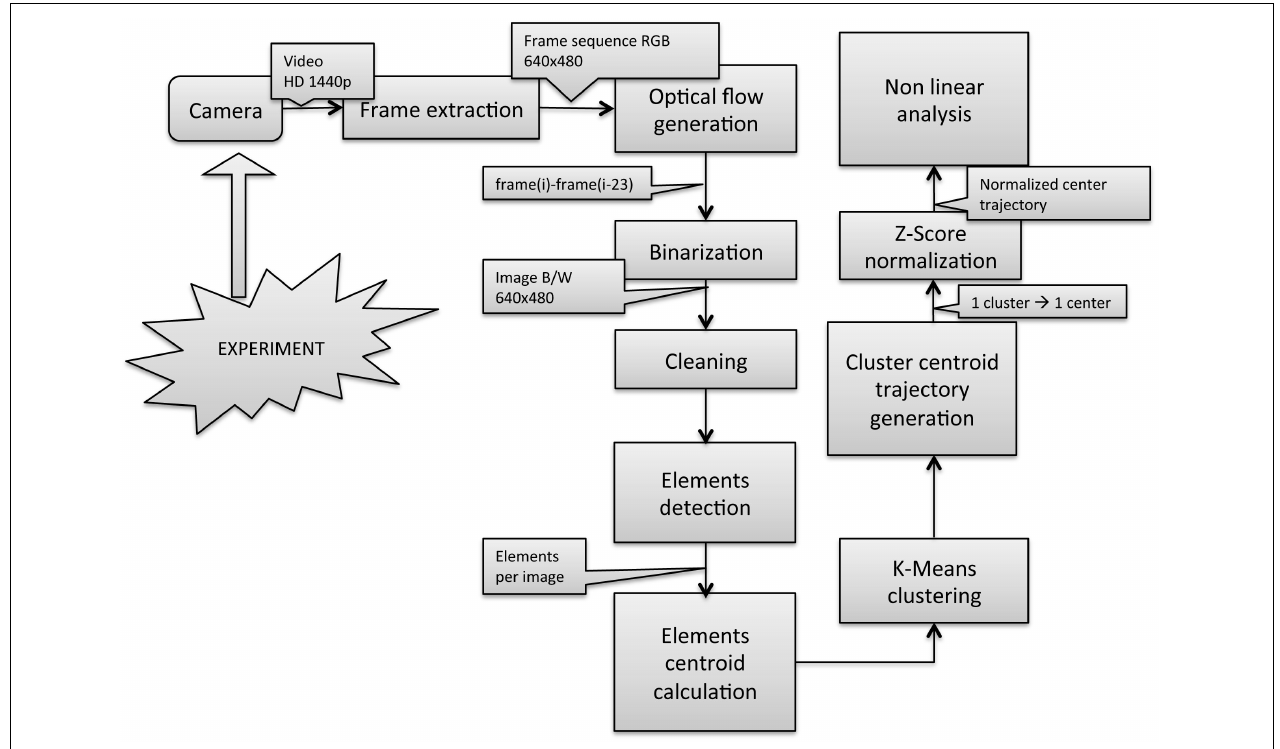
FIGURE 4 | Data acquisition and processing workflow. Taken from Eguiraun et al.